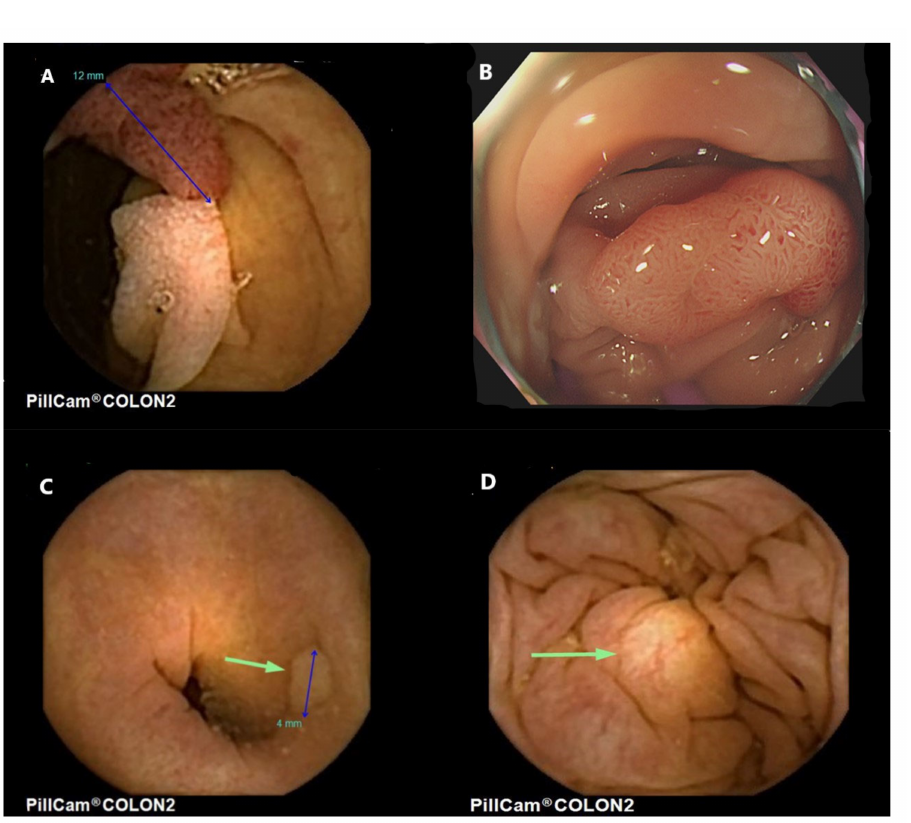
Figure 1. Colon polyps seen from colon capsule endoscopy. ( A ). Pedunculated adenomatous polyp in the sigmoid colon, ( B ). The same pedunculated polyp as seen at colonoscopy. Histology revealed an adenoma with low grade dysplasia, ( C ). Diminutive hyperplastic polyp, ( D ). A submucosal lesion in the colon with yellowish appearance consistent with a probable